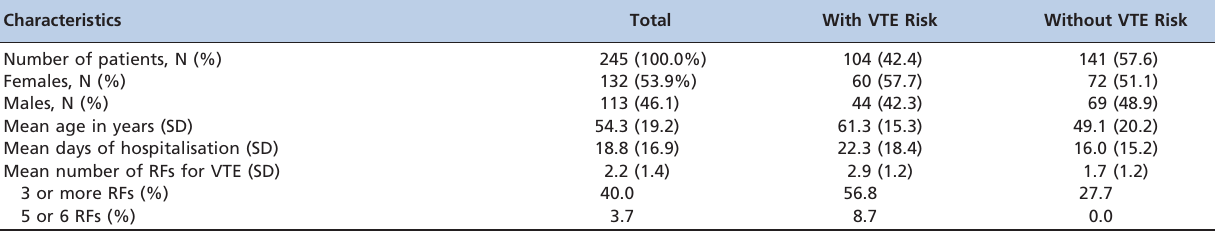
VTE, venous thromboembolism; SD, standard deviation; RFs, risk